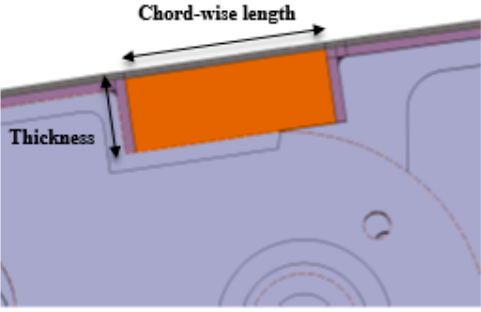
Figure 11. Detail of the gap at the hinge: assembly of the flexible foam.